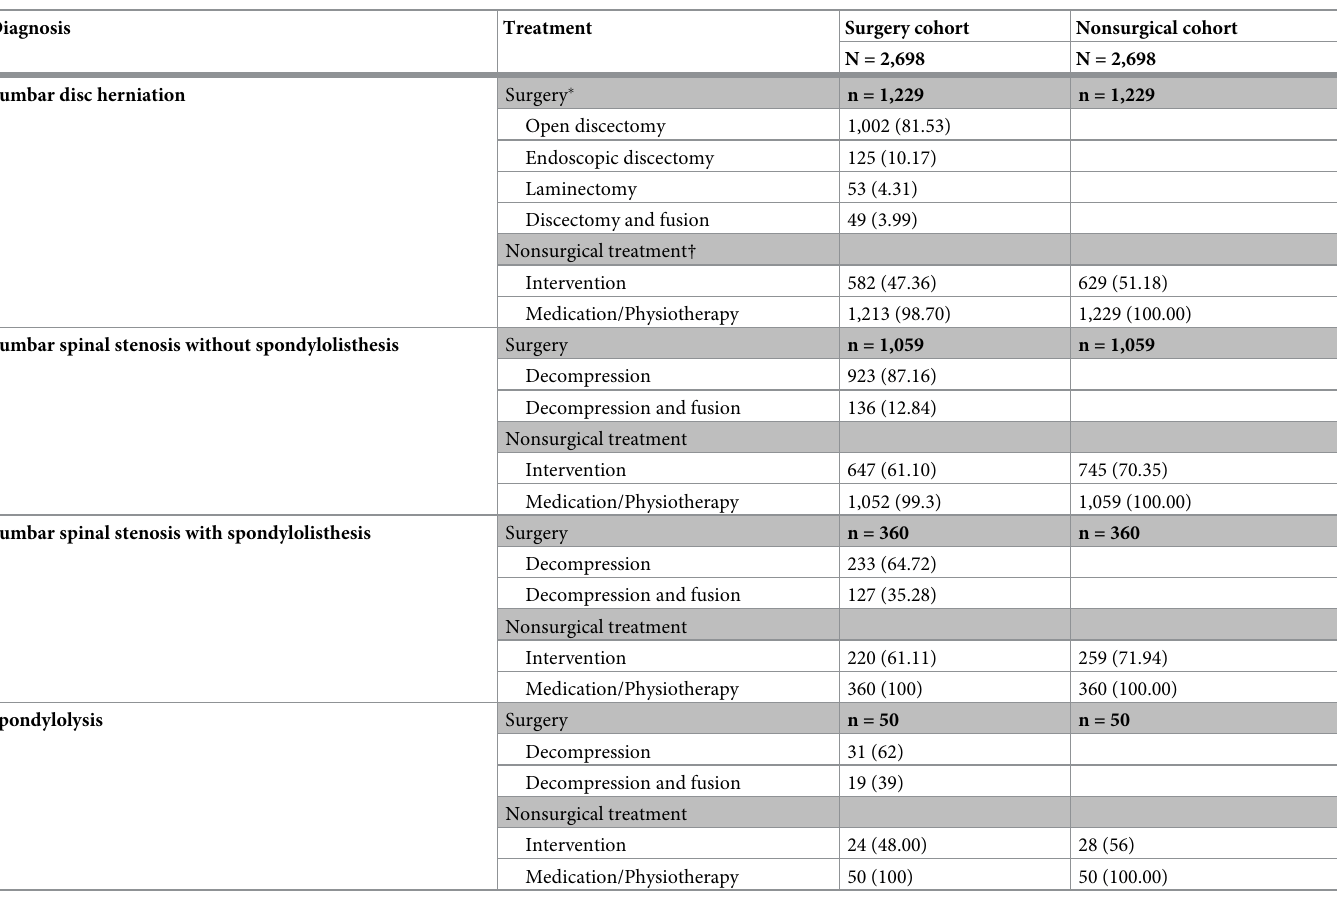
Table 2. Details of the